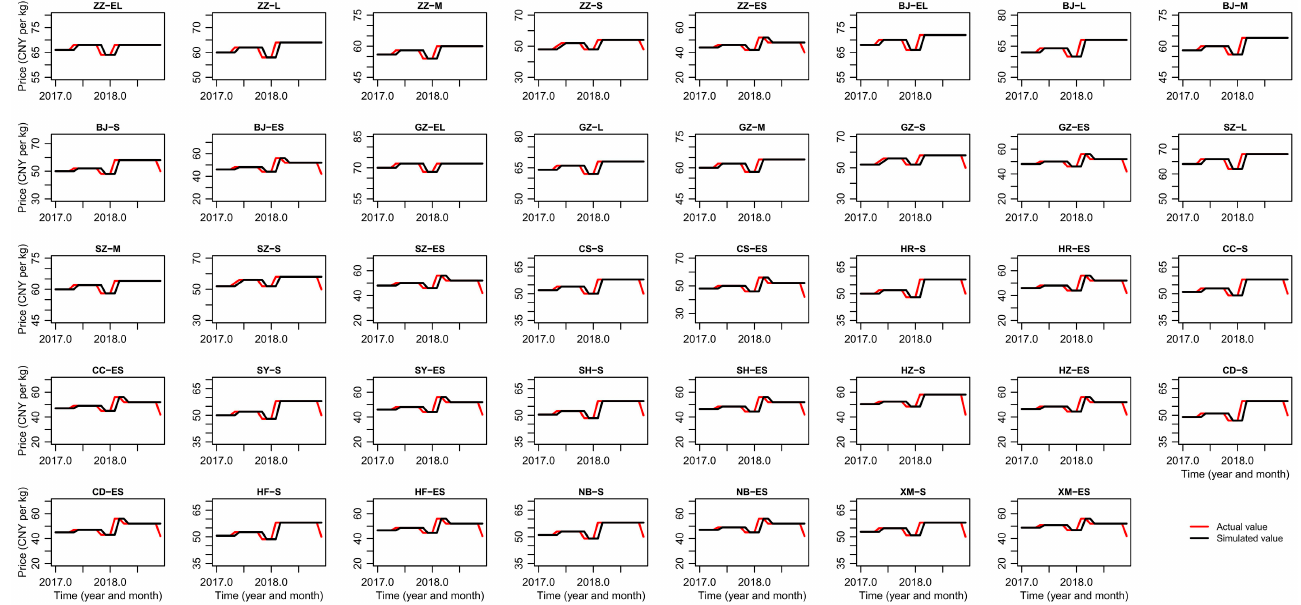
Figure 6. The actual value and simulated value of each specification price in the ZZ group.